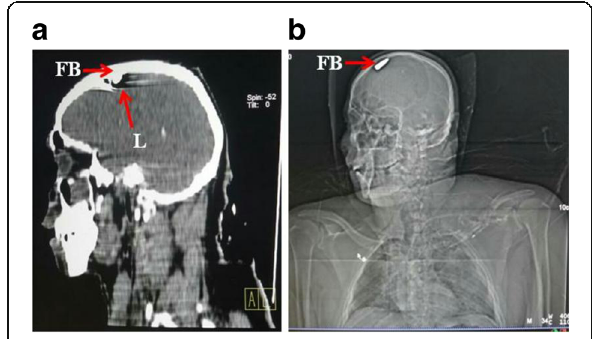
Fig. 2 Gunshot injuries of the head. a MDCT sagittal reformatted image showing the entry wound, wound channel (arrow) with cerebral lacerations (L), and a dense metallic foreign body in the high parietal region (FB). b Scanogram image showing a dense metallic foreign body in the high parietal region